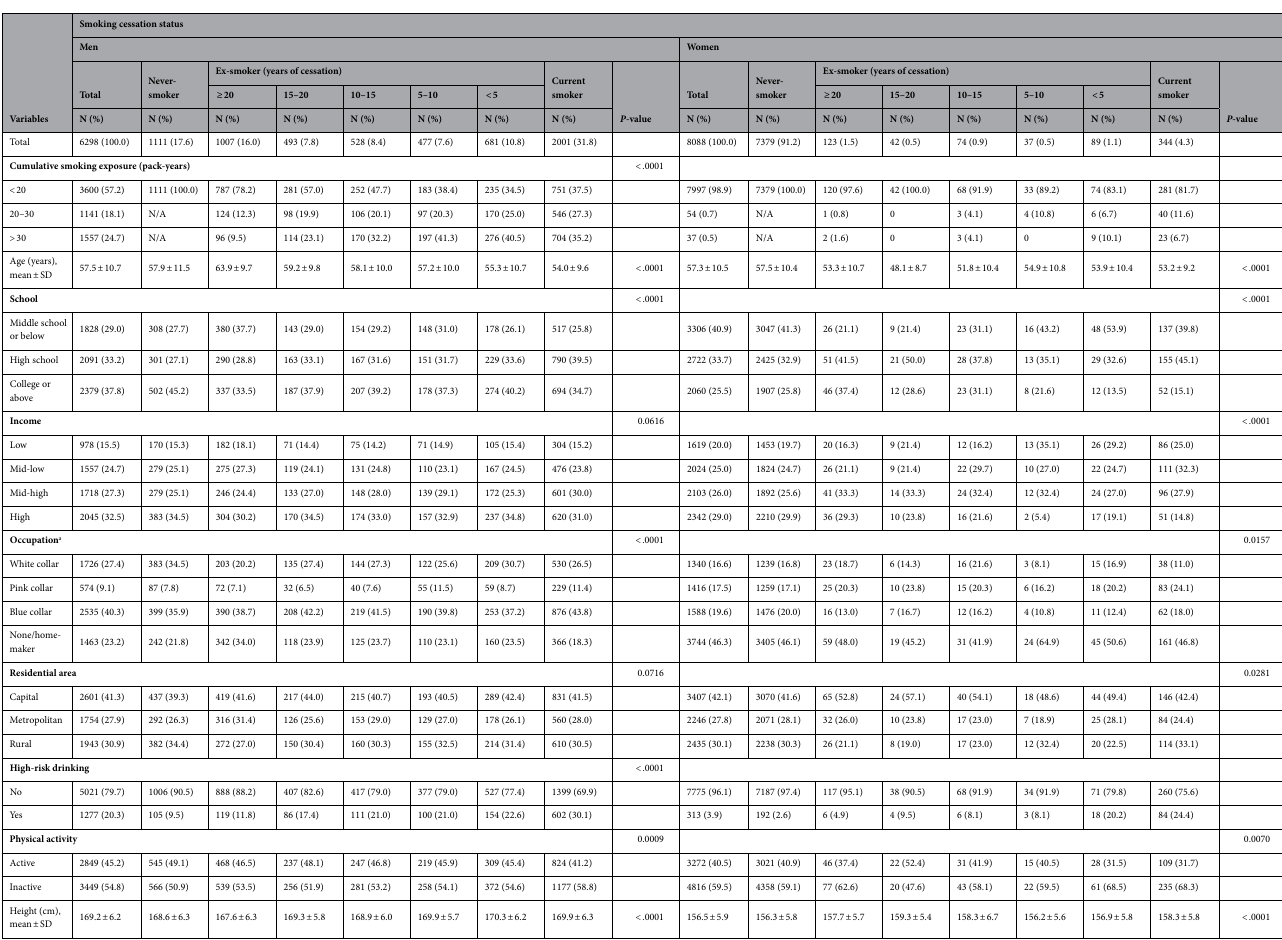
Table 1. General characteristics of the study population. SD standard deviation. a Based on the International Standard Classification Occupations